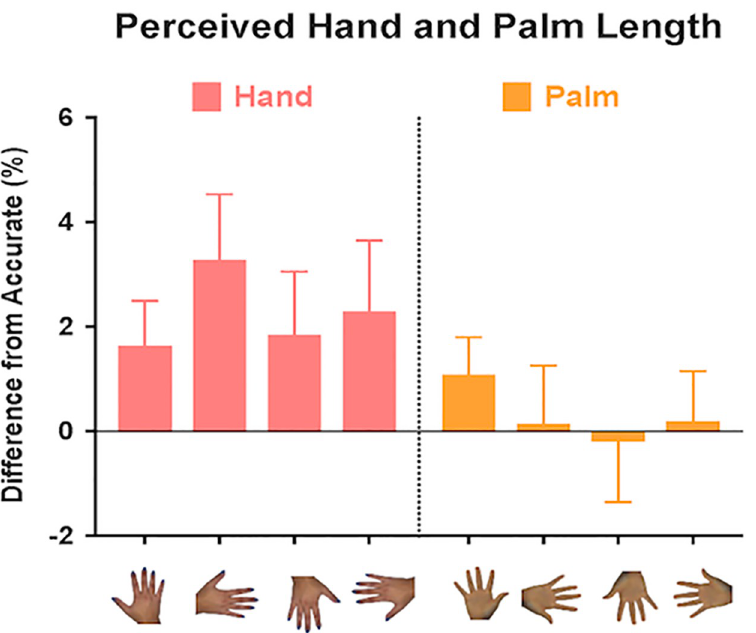
Fig 3. Perceived dorsum and palm length. Mean differences from accurate when dorsum (left panel) or palm (right panel) was distorted in the length dimension for each viewing orientation. Positive and negative scores represent overestimation and underestimation respectively. Error bars represent ± 1